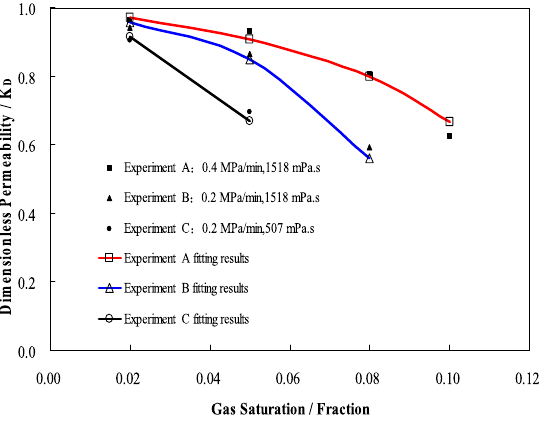
Figure 3. Redefined relative permeability as a function of gas saturation for the three experiments conducted under different conditions.